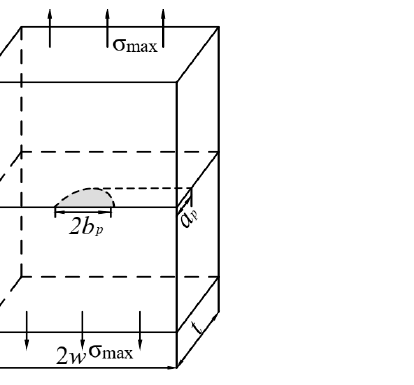
Figure 12. Equivalent model of a corrosion pit: ( a ) 3 days; ( b ) 7 days; ( c ) 15 days; ( d ) , ( e ) and ( f ) 30 days. Many scholars have previously established fatigue life prediction models by combin- ing the crack growth rate formula with the initial crack length and the critical crack length when fracture occurs [25,26]. The rate of crack growth d a /d N is commonly used to indicate the crack growth performance of metal materials. Herein, the fatigue life prediction of the 5083/6005A was made based on Paris law [27] as given by: (